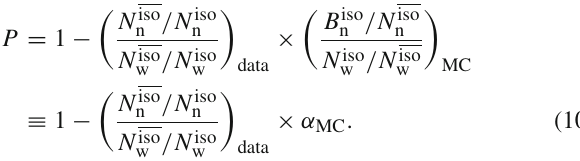
), used to estimate long < 2GeV / c T > 3GeV / c T